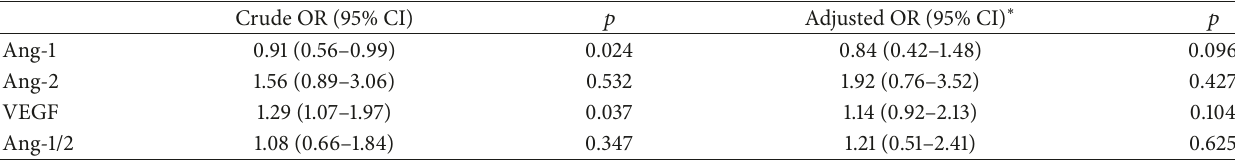
Table 3: Logistic regression models of peripheral arterial disease and vascular growth factors.